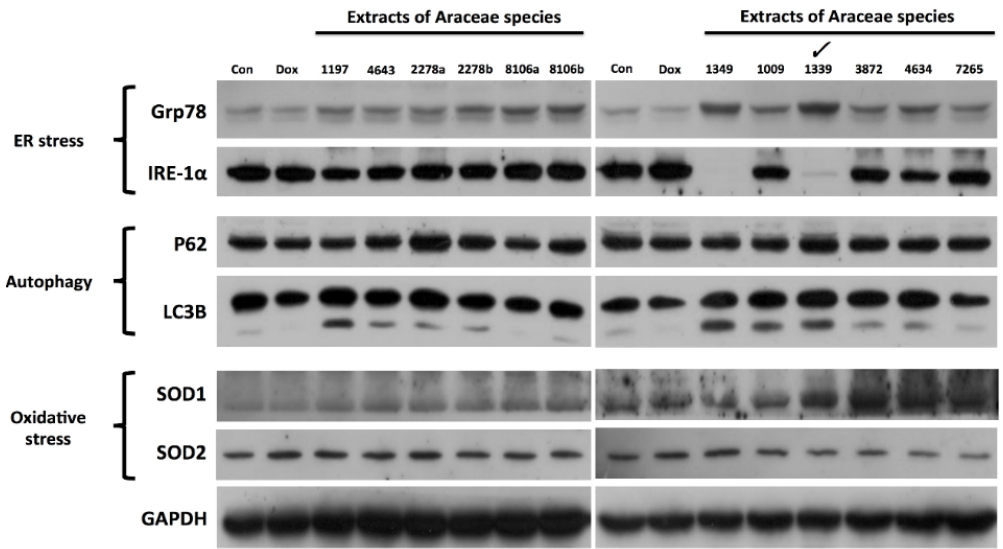
Figure 1. Identification of ethyl acetate extract of Scindapsus cf. hederaceus as a novel UPR modulator. The 12 samples of 10 plant species, labeled as 1197 (ethyl acetate), 4643 (ethyl acetate), 2278a (ethyl acetate), 2278b (water), 8106a (water), 8106b (butanol), 1349 (methanol), 1009 (ethyl acetate), 1339 (ethyl acetate), 3872 (ethyl acetate), 4634 (hexane), and 7265 (ethyl acetate), were collected from Dr. Cecilia Koo Botanic Conservation Center, Kaohsiung County, Taiwan. Ethyl acetate extract of Scindapsus cf. hederaceus (SH-EAE) was labeled as 1339 and stored at − 20 ◦ C for the screening of biological activity. H1299 cells were exposed to a single dose (20 µ g/mL) of 12 extracts from a family Araceae for 48 h followed by immunoblot assay. The protein levels of Grp78, IRE-1 α , SQSTM1, LC3, SOD1, and SOD2 were evaluated. Dimethyl sulfoxide (DMSO) as vehicle control. Dox, Doxorubicin. Glyceraldehyde-3-phosphate dehydrogenase (GAPDH) was used as the loading